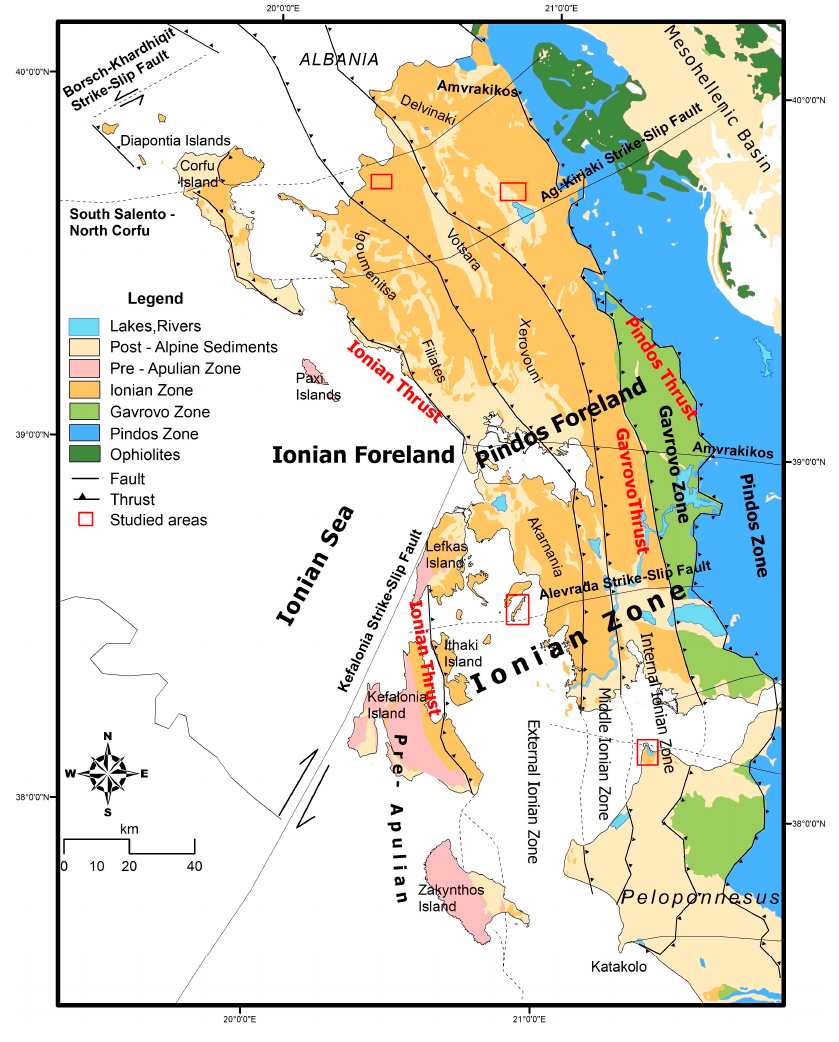
Figure 1. Geological map of the external Hellenides in NW Greece illustrating the principal tectonostratigraphic zones: Pindos, Gavrovo, Ionian, and Pre-Apulian Zones (modified from [10]). Red boxes show the studied areas of Kastos Island, in the external Ionian zone, and Araxos peninsula (NW Peloponnesus), in the internal Ionian zone, as well as previously studied areas in the Gotzikas area, in the middle Ionian zone, and Ioannina areas, in the internal Ionian zone.